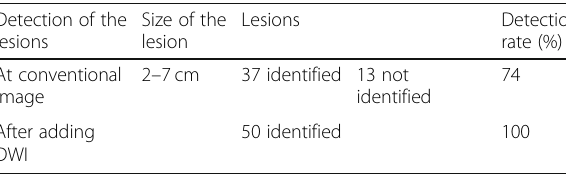
Table 2 Comparison between detection of the lesion at conventional and DWI Detection of the Size of the lesions lesion